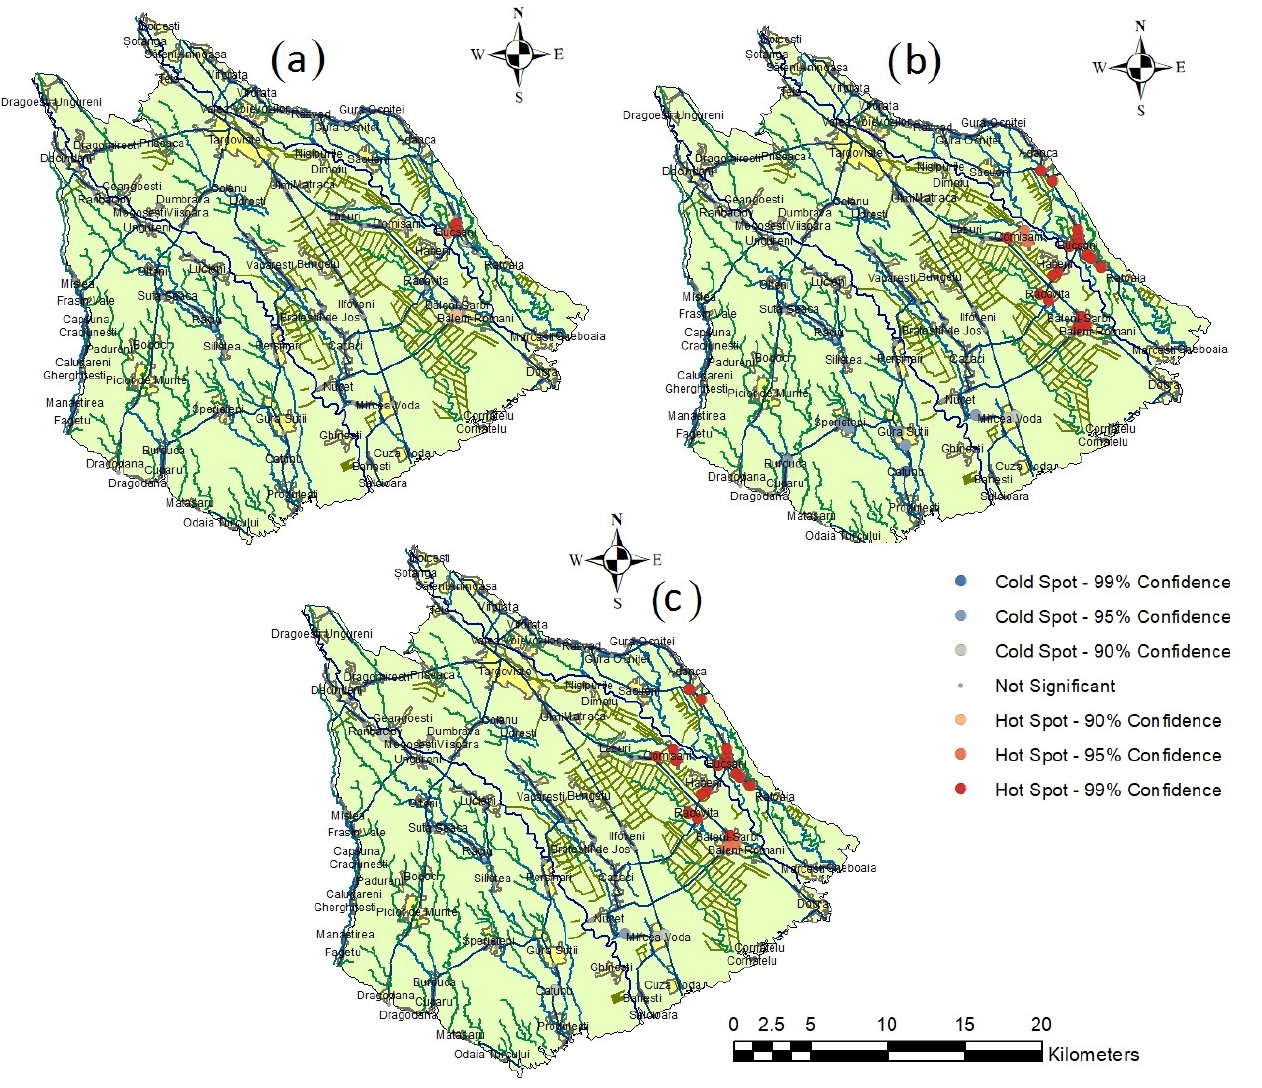
Figure 7. Hot-spot analysis for the eastern part of Târgovi ş te Plain for each of the three scenarios: ( a ) WQI scenario 1; ( b ) WQI scenario 2; ( c ) IwWQI scenario. HSA for WQI Scenario 1 did not find a large area in which wells qualified as hot